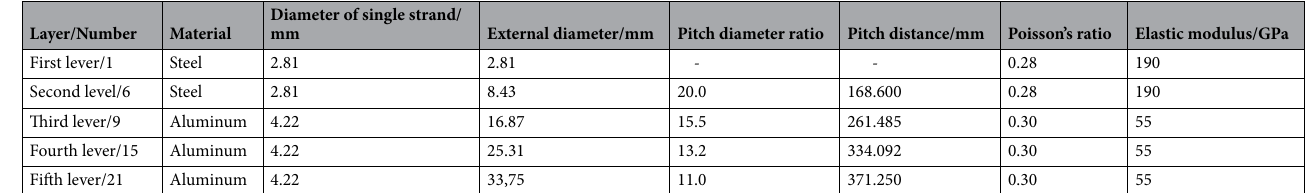
Table 8. Structural parameters of JL/G1A-630–45/7